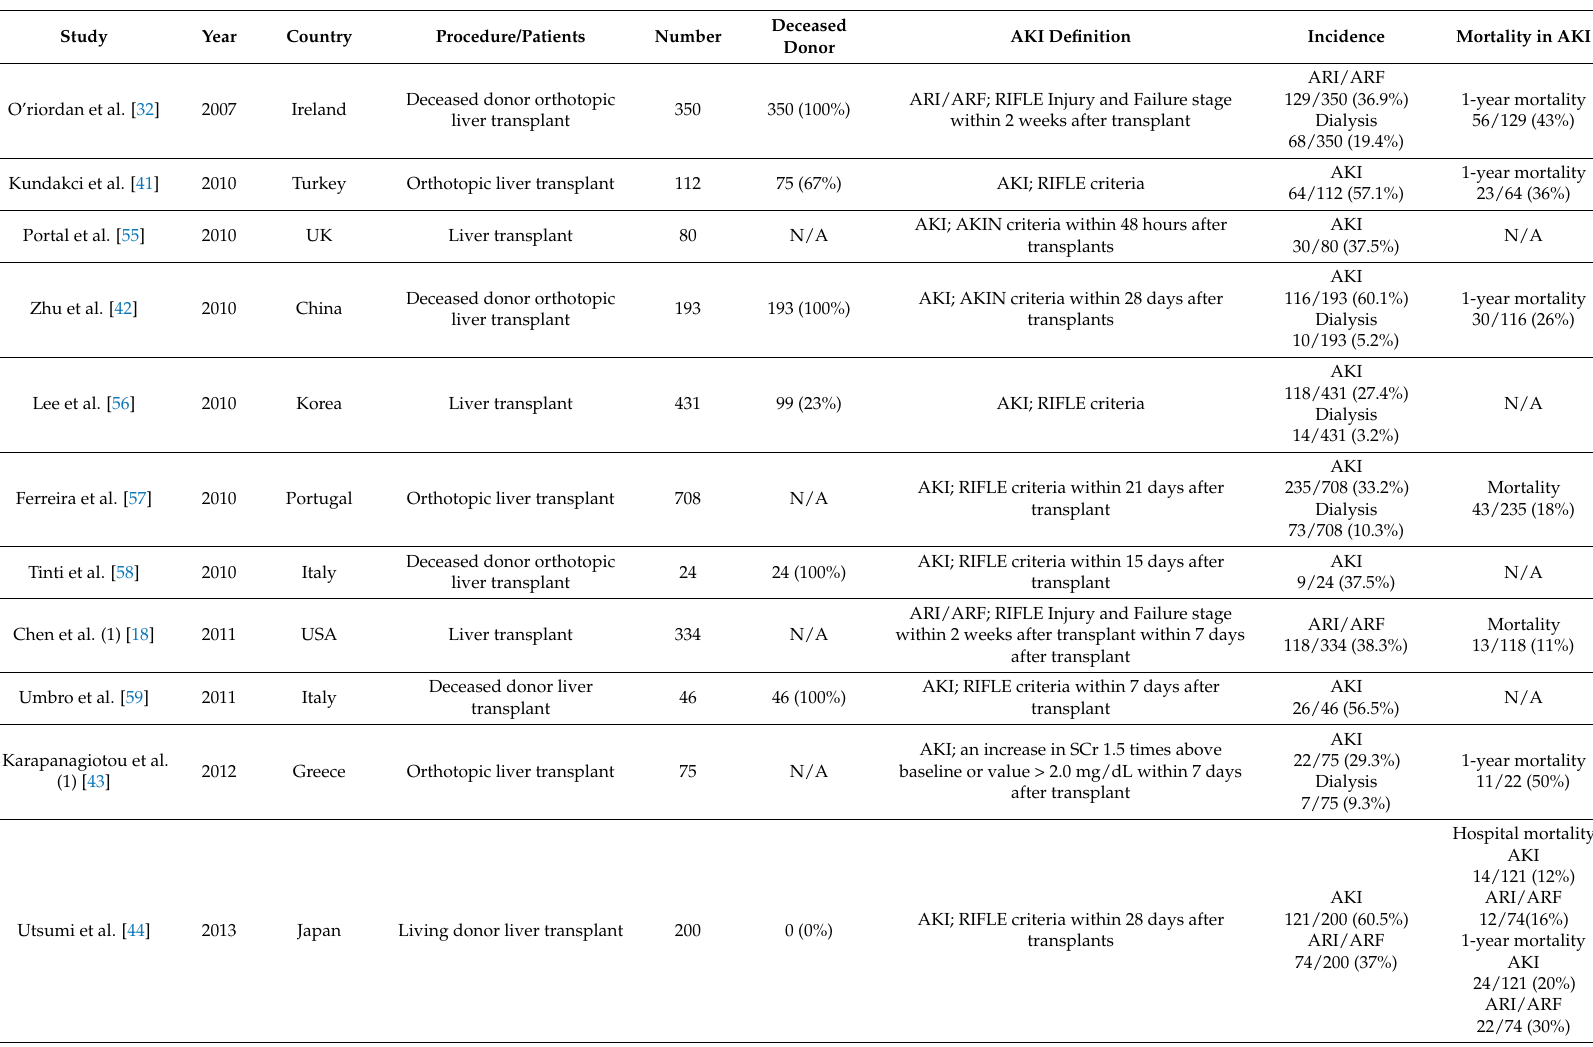
Table 1. Main characteristics of studies included in meta-analysis of AKI in patients undergoing LTx [14,18,19,21,28–32,39,41–44,48,49,55–60,62–66,69,70,72–80]. Study Year Country